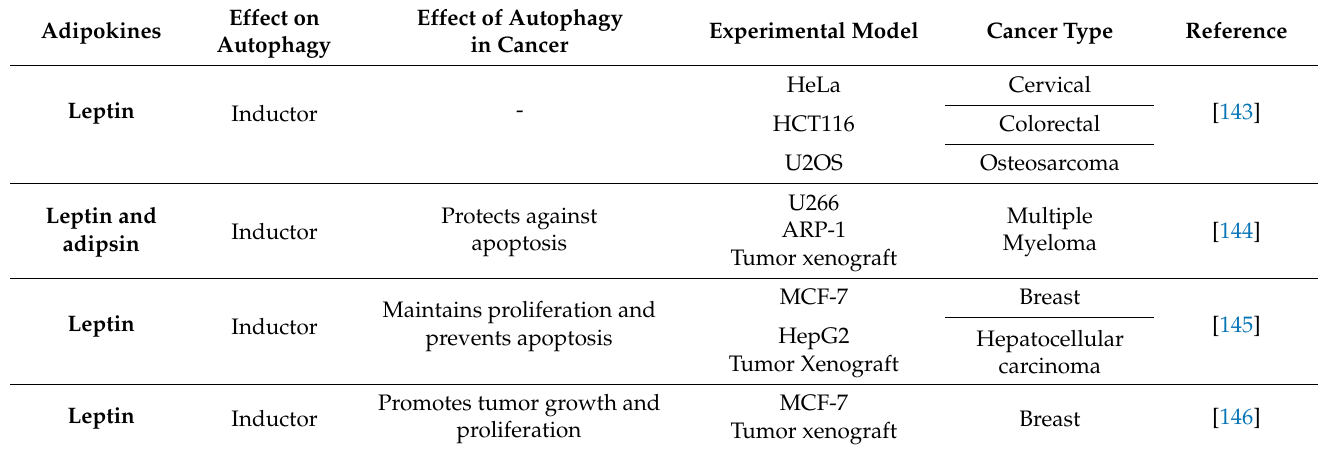
Table 2. Effects of adipokines on autophagy in different cancer models. In several experimental models, it has been shown that the exogenous addition of adipokines induces autophagy and promotes cancer progression. Although adiponectin is found at low levels in an obese individual, it has been shown that exogenous adiponectin induces autophagy, which is a key mechanism for some antitumor effects induced by